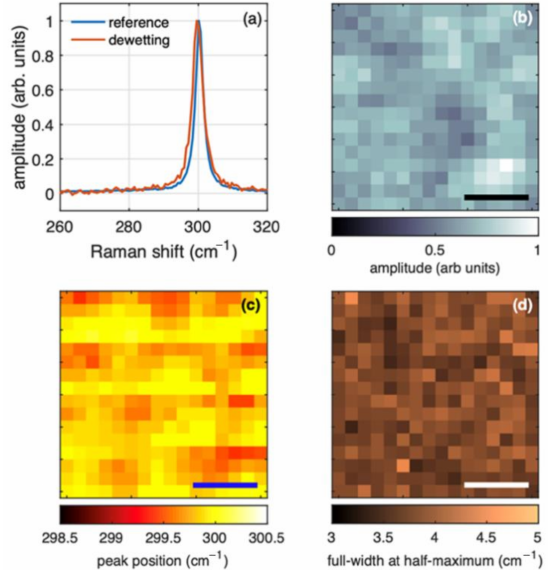
Figure 6. Raman spectroscopy of sample S6 (dewetting by annealing at 780 ◦ C). ( a ) Comparison of normalized spectra from the dewetted germanium islands and a reference bulk germanium sample. ( b – d ) Spectral features from a Raman map collected from a 3 µ m × 3 µ m region with a sampling grid of 0.2 µ m. ( b ) Amplitude. ( c ) Peak position. ( d ) Full width at half maximum. The thick mark in ( b – d ) is 1 µ m